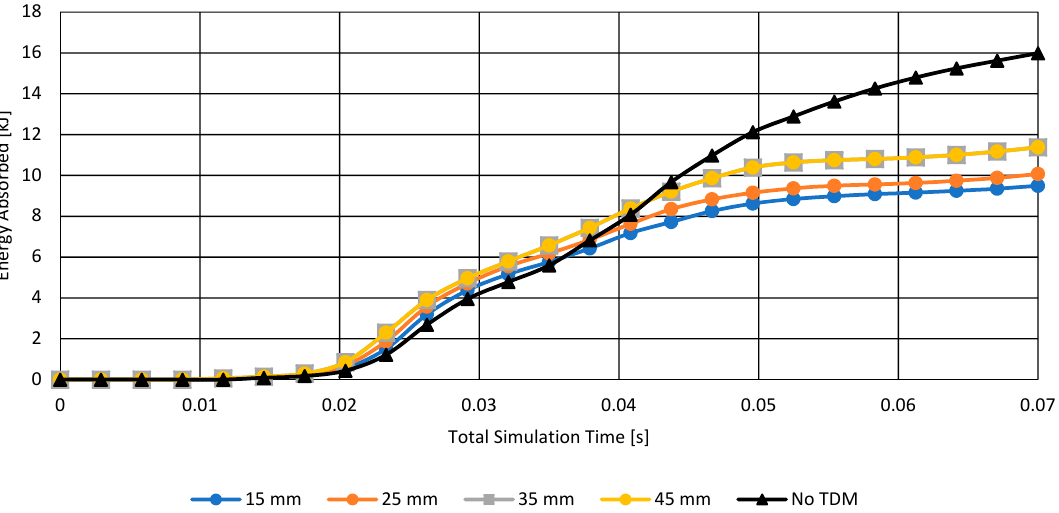
Figure 8. FEA results of energy absorptions of the street pole after being collided by a vehicle (corner collision scenario) using five different thicknesses of TDM shielding.